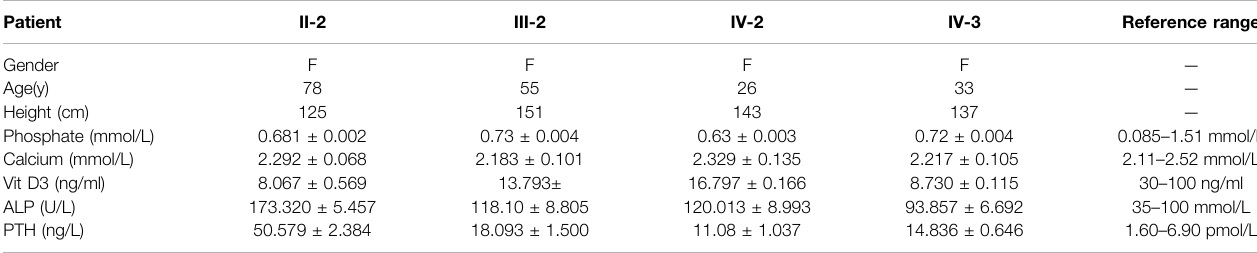
TABLE 1 | Clinical and biochemical features of the family under study.